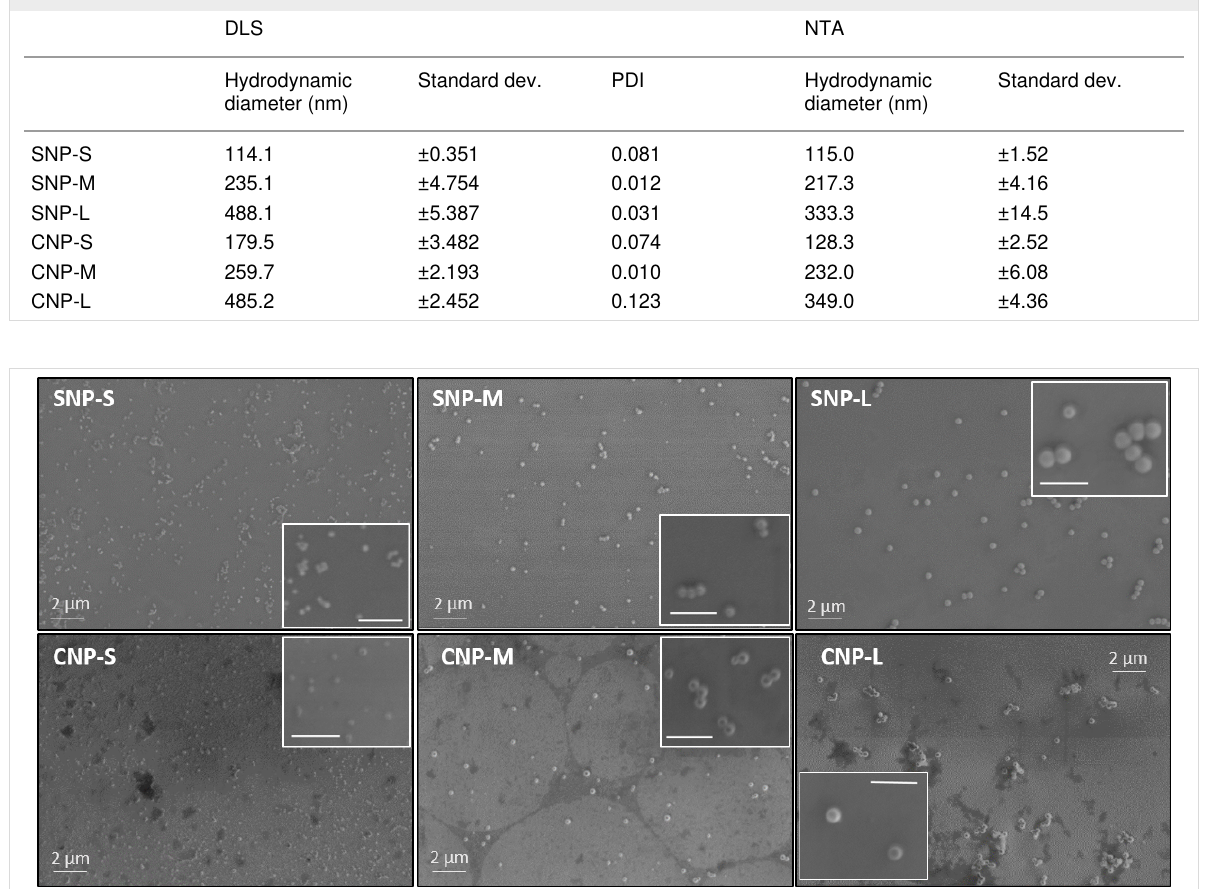
Table 3: Mean hydrodynamic diameter, PDI and standard deviation of each sample measured after purification obtained with DLS compared with the mean of hydrodynamic diameter and standard deviation obtained using NTA.